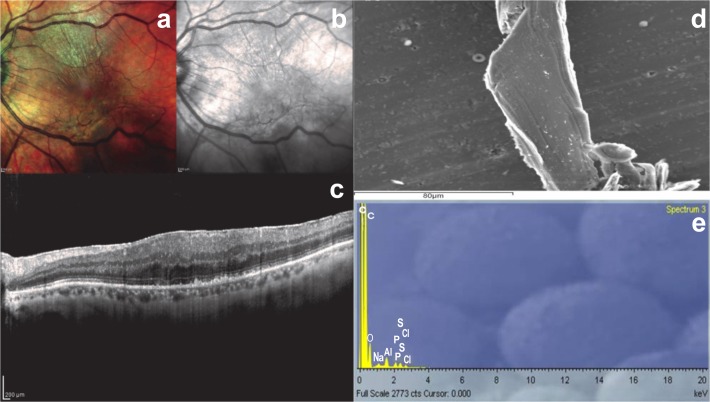
Analysis of a sample ERM with smooth appearance at SEM.a-c) Multicolor image, infrared and structural OCT B-scan showing slight epiretinal proliferation; d) Scanning electron microscope sample revealing smooth tissue; e) SEM/EDS analysis showing the mineral composition of the sample: sulphur, sodium and phosphorus are the most frequent elements.